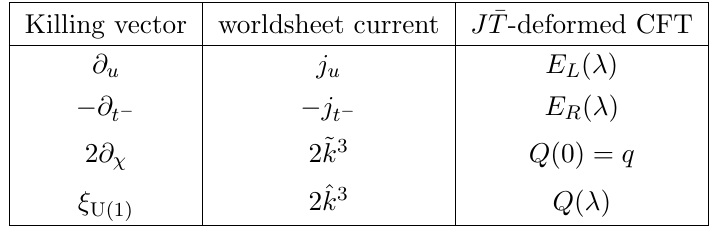
Table 1 . Killing vectors and their corresponding worldsheet currents and (cid:12)eld theory